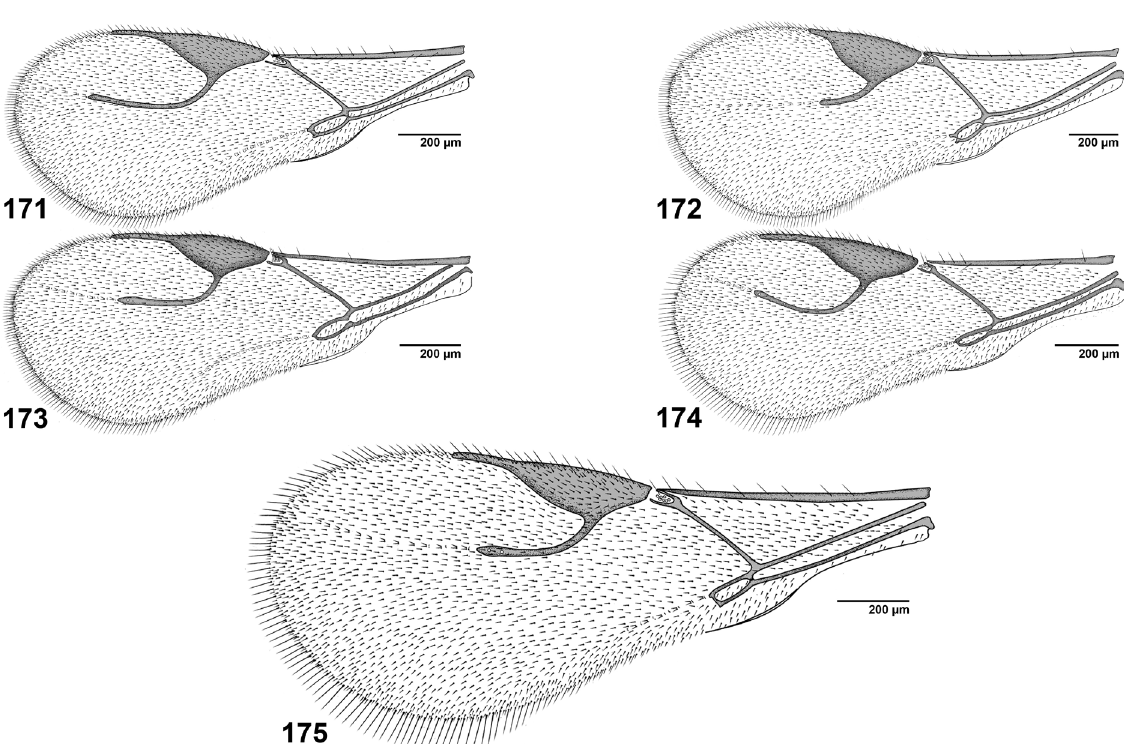
Figs 171–175. Forewing (♀): 171 . Trioxys pallidus . 172 . Trioxys pannonicus . 173 . Trioxys pappi . 174 . Trioxys quercicola . 175 . Trioxys tanaceticola